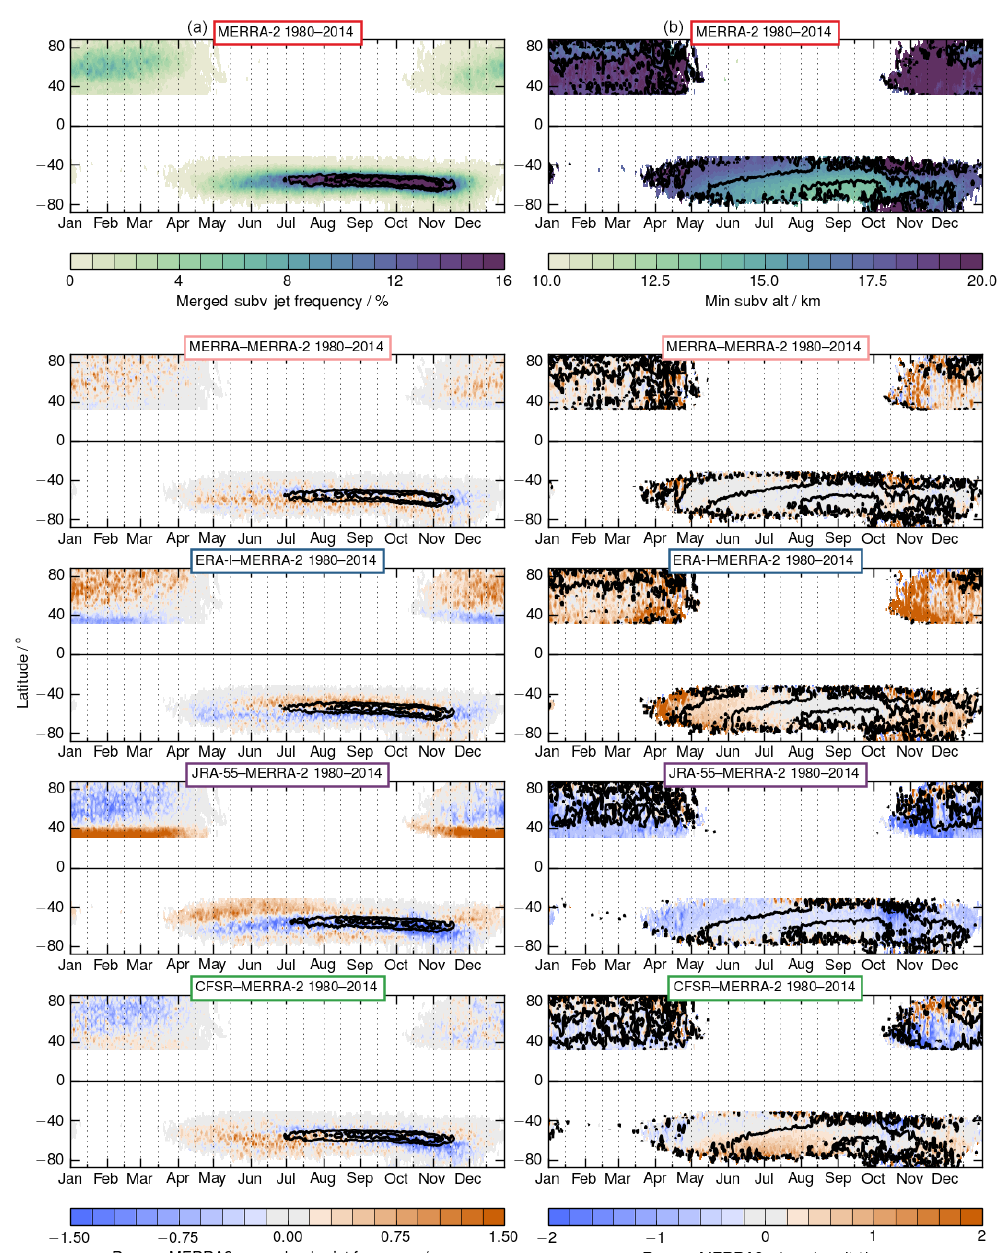
Figure 16. As in Fig. 13, but for merged subvortex jet frequency distributions on the left (a) and merge altitude on the right (b) . Overlaid contours are 12 and 16% for frequencies and 14 and 18km for merge altitudes; the smallest value is always the largest or “outermost” contour. In the difference plots, blues/oranges indicate negative/positive